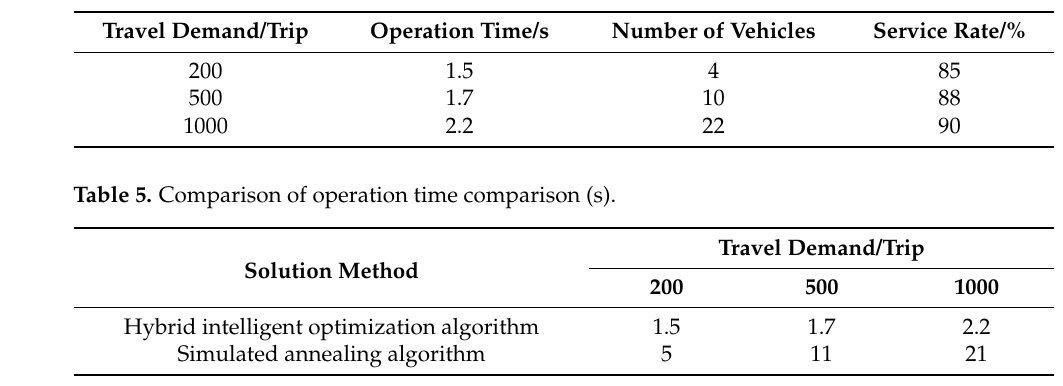
Table 4. Comparison of operation parameters of different travel demand.